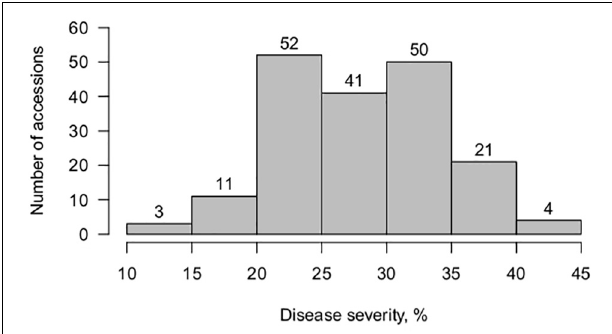
FIGURE 1 | Frequency distribution of Uromyces pisi -induced disease severity (DS) scores (%) in a worldwide collection of 182 grass pea accessions.